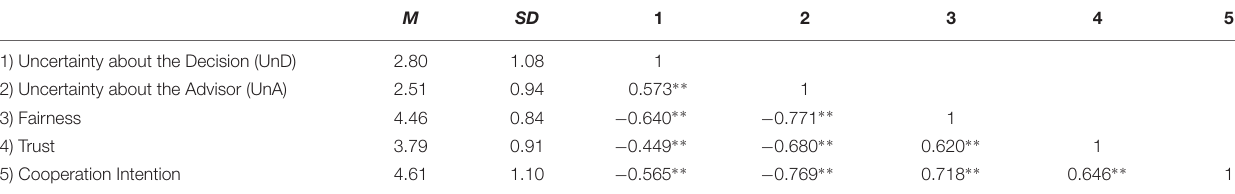
TABLE 1 | Intercorrelations between all measured variables. M SD 1